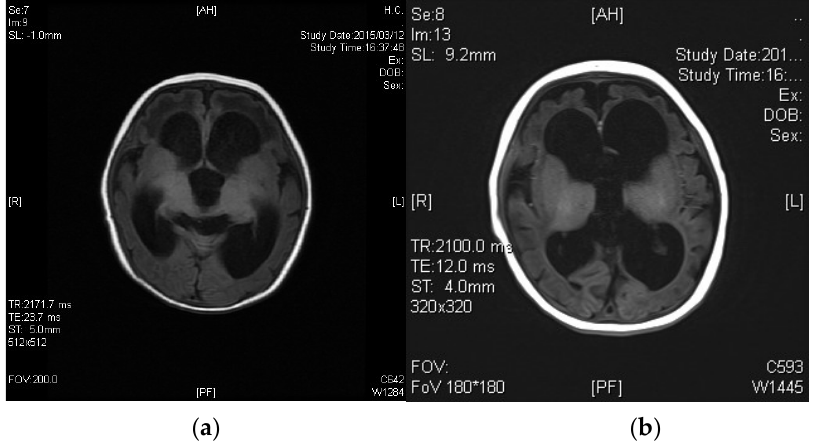
Figure 2. Brain MRI of Case 2. ( a ) At 2.5 months of age (T1); ( b ) 4 months of age (T1) showing no effect on the ventricular size after ventricular drainage.